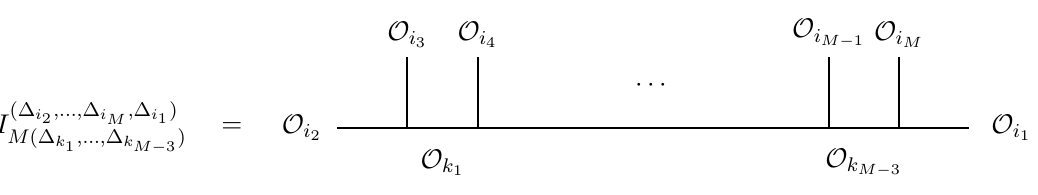
Figure 1 . Conformal blocks in the comb